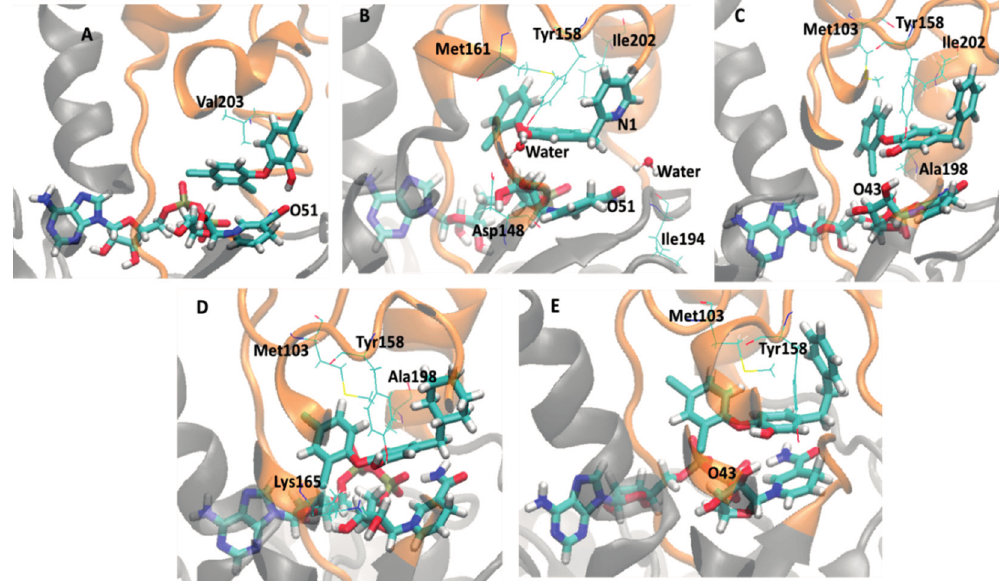
Figure 9. Close view of the active site of the InhA-NADH (orange) in complex with triclosan (TCL) and its derivatives (8PC, JPM, JPL, and JPJ), showing important residues and water molecule. NADH and inhibitors are shown as stick models colored by element (carbon, cyan; hydrogen, white; nitrogen, blue; oxygen, red; sulfur, yellow). ( A ) InhA-NADH-TCL (2B35); ( B ) InhA-NADH-8PC (3FNE); ( C ) InhA-NADH-JPM (3FNF); ( D ) InhA-NADH-JPL (3FNG); ( E ) InhA-NADH-JPJ